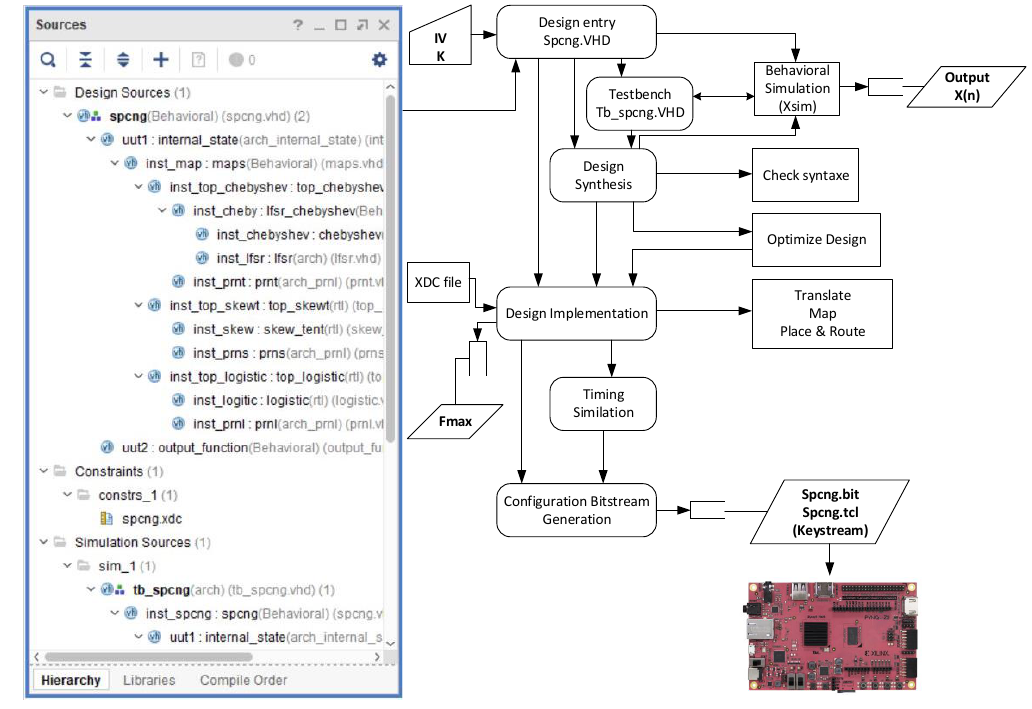
Figure 5. FPGA conception flow (under Vivado) of the proposed